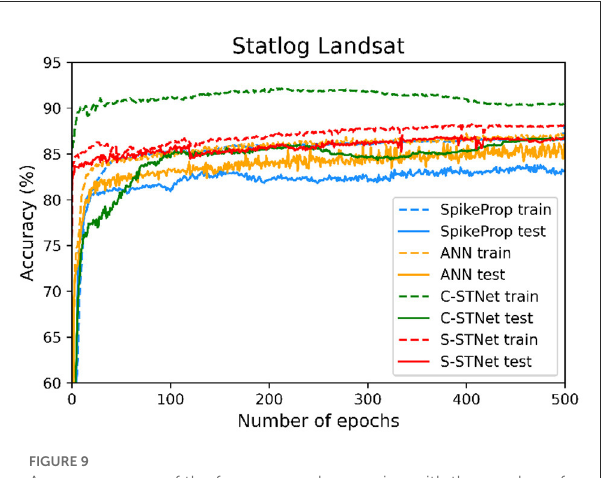
FIGURE9 Accuracy curves of the four approaches varying with the number of epochs.